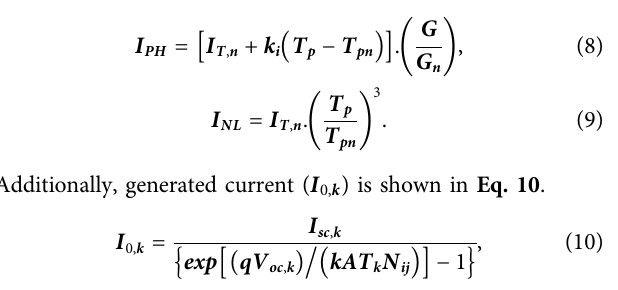
Frontiers in Energy Research |